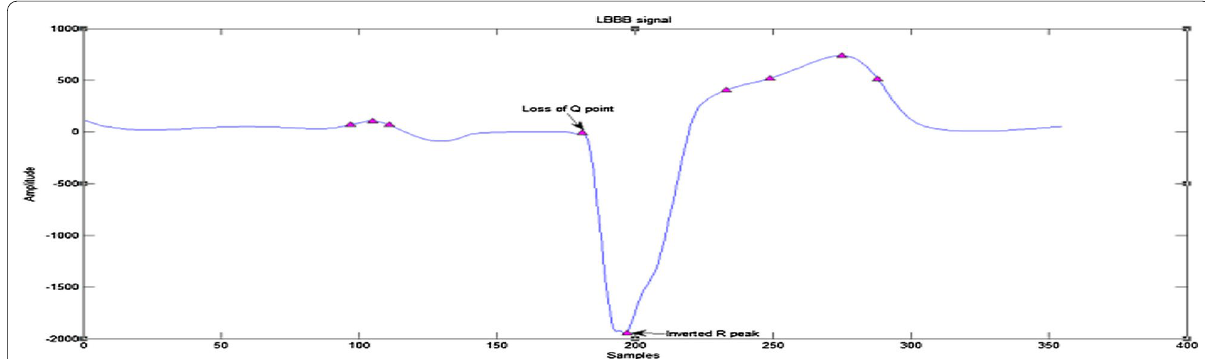
Fig. 15 Averaged signal of LBBB of record 111 and detected fiducials: The figure shows the folded signal of LBBB arrhythmia based on the period-dependent gate which gives the averaged information about the signal